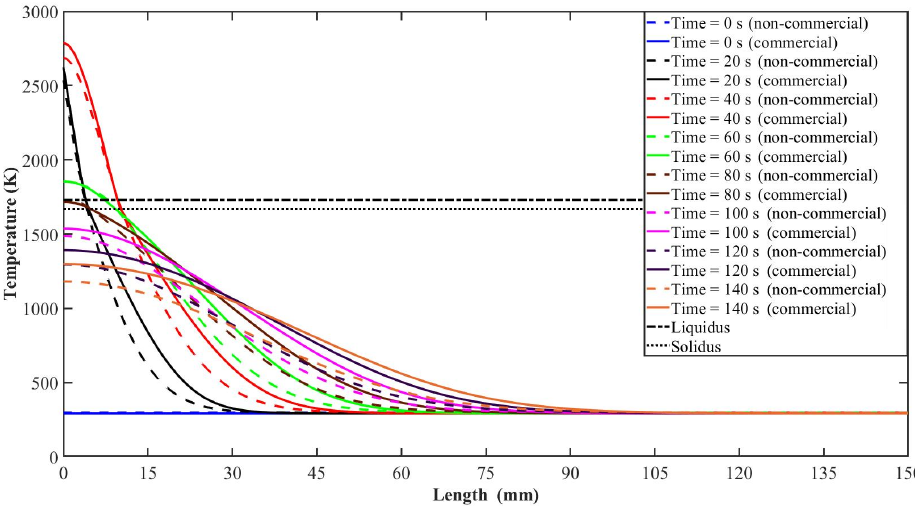
Figure 8. Comparison of temperature distribution obtained by the non-commercial and commercial model along the length of the cylindrical